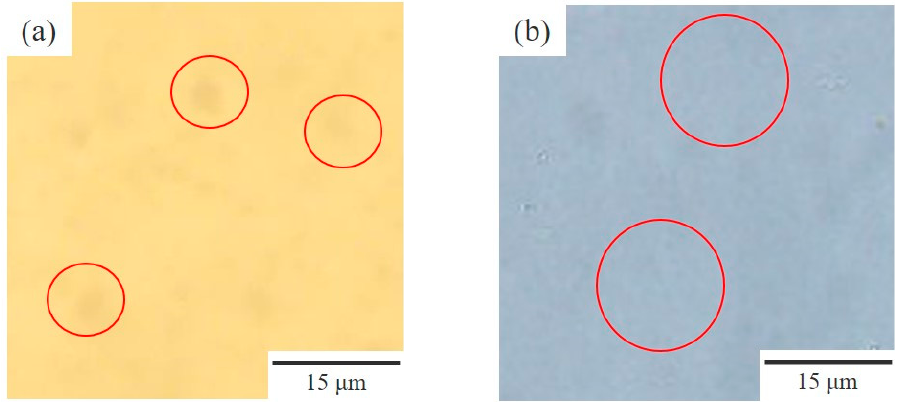
Figure 3. Optical micrographs of 60/40 NBR/PVC: ( a ) melt-mixed blend at 150 °C with additives; ( b ) annealing the solvent-cast film at 150 °C without additives.